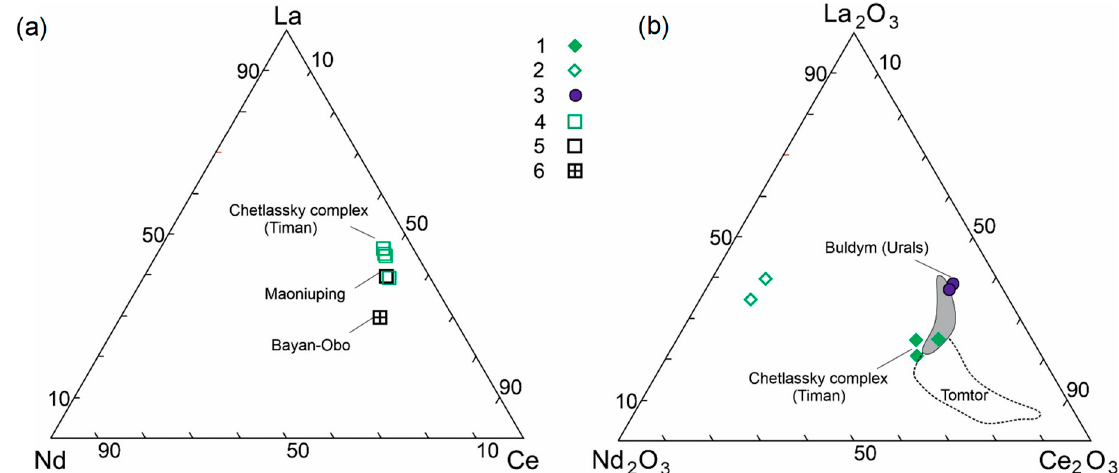
Figure 10. Chemistry of bastnäsite and monazite: ( a ) ternary diagram with major REE cation vertices showing bastnäsite compositions; ( b ) ternary diagram showing relative La 2 O 3 , Ce 2 O 3 , and Nd 2 O 3 (wt%) contents in monazite: 1, 2—monazites of Chetlassky complex (M. Timan) [84]: 1—early Mnz I, 2—late Mnz II; 3—monazites of Buldym complex (S. Urals); 4–6—bastnäsites from: 4—Chetlassky complex (M. Timan); 5—Maoniuping, China, 6—Bayan Obo, China. Monazite compositions in carbonatites of other localities worldwide are plotted for reference: Siberian craton (Tomtor rare-metal deposit), China craton with Qinling and Mianning–Dechang orogenic belts (Bayan Obo, Dashigou, Yuantao, Miaoya, Daluxiang and Maoniuping REE-deposits) (grey field) [152–156].